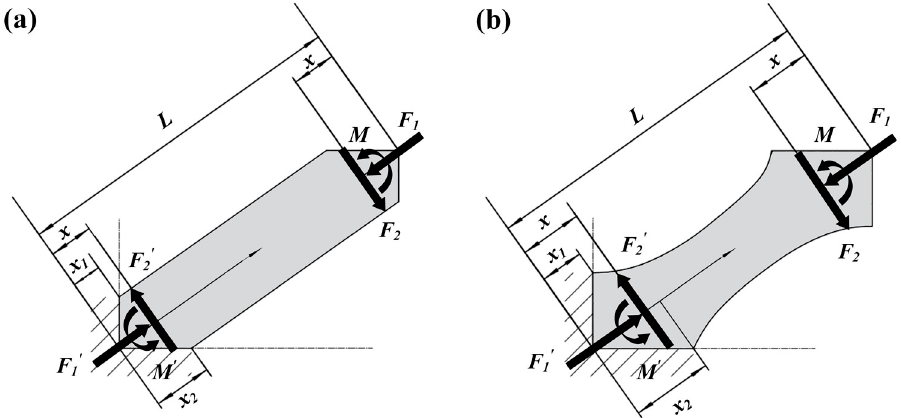
Figure 10. Simplified theoretic mode of ( a ) CAD-based BCC structures and ( b ) TPMS-based BCC structures.